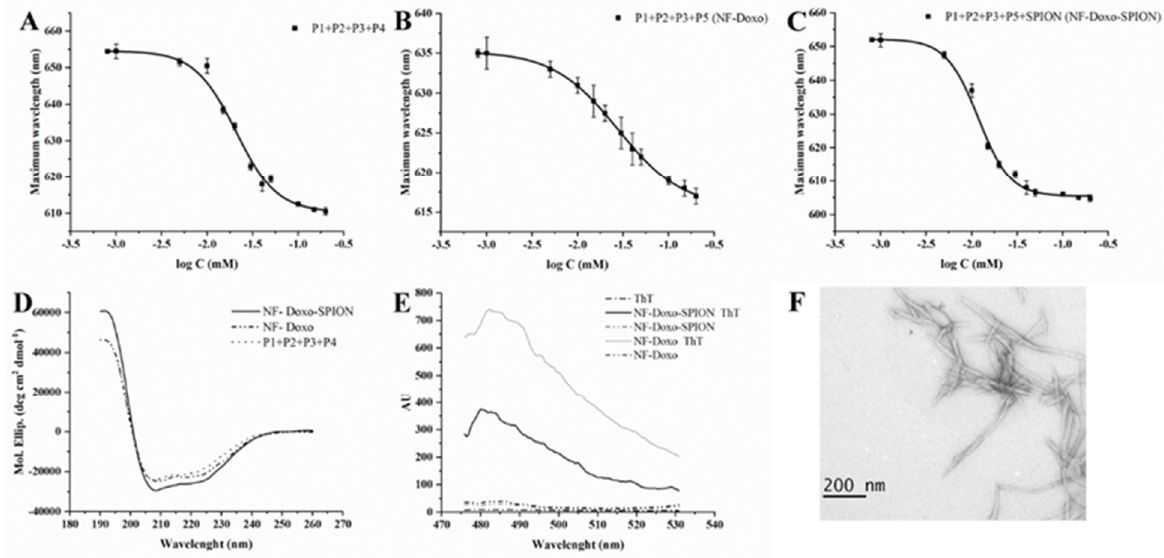
Figure 5. Fiber formation and characterization: CAC ( A – C ), CD results ( D ), Tht results, ( E ) TEM ( F ) for NF-Doxo, and NF-Doxo-SPION. Graphs were created with OriginPro 2021.